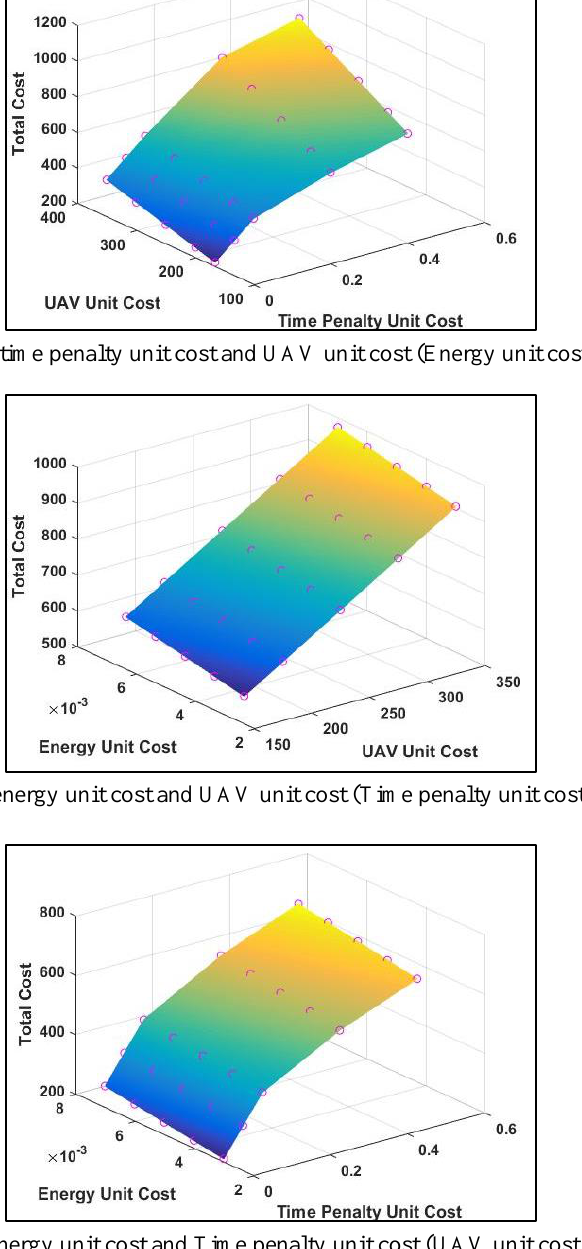
Figure 3. Sensitivity analysis on the coefficients of the objective